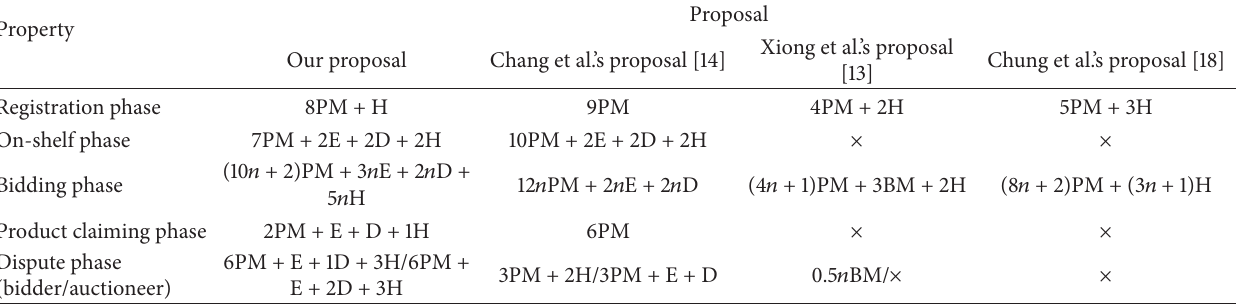
Table 2: Comparison in computational cost of the three